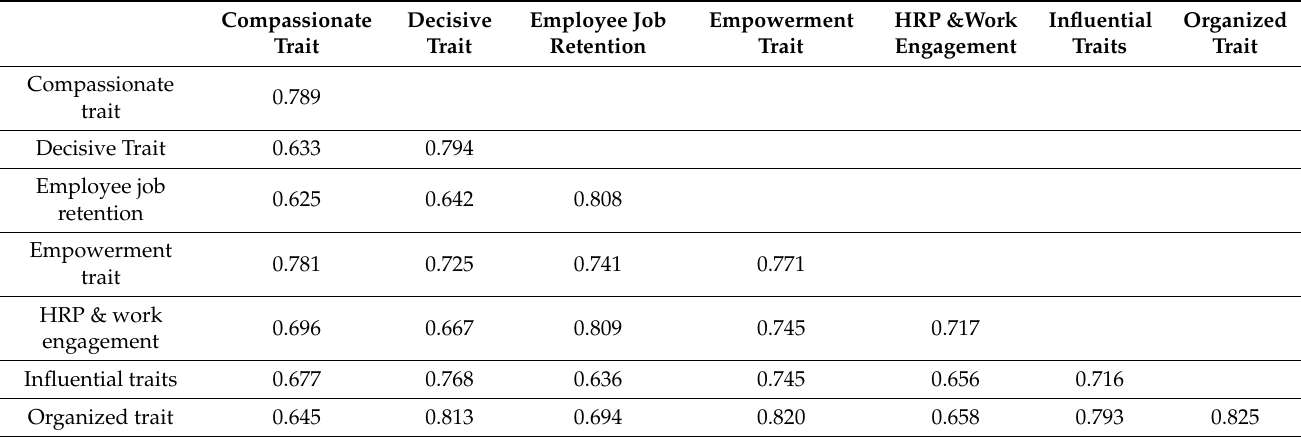
Table 3. Fornell–Larcker Criterion.